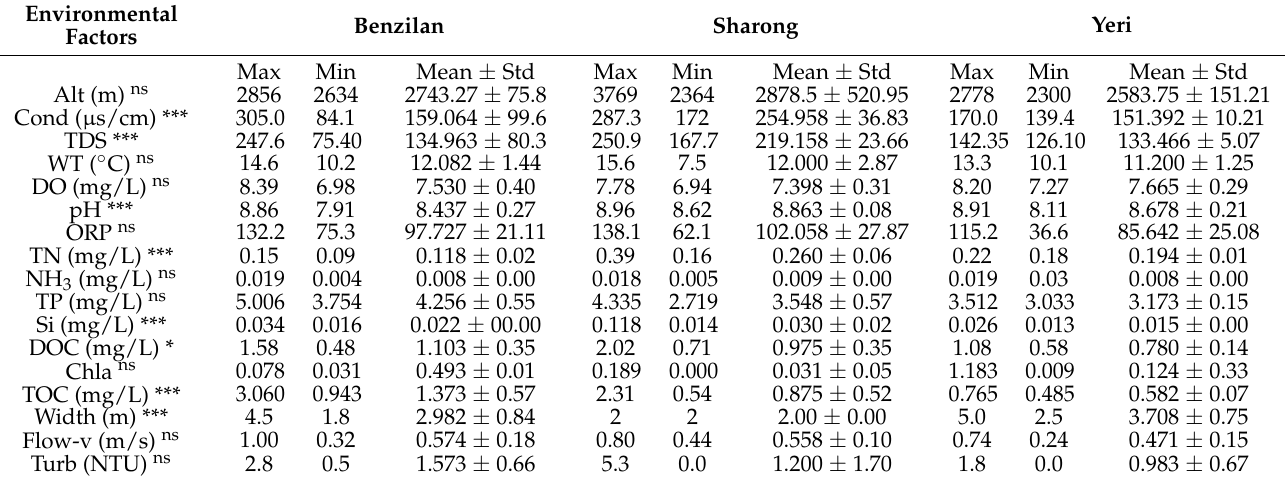
Table 1. Basic statistics of physicochemical parameters and results of the ANOVA and nonparametric Kruskal–Wallis for the three streams. The superscripts “*” and “***” indicate a statistically significant effect at p < 0.05 and p < 0.001, respectively, while “ns” stands for not significant ( p >